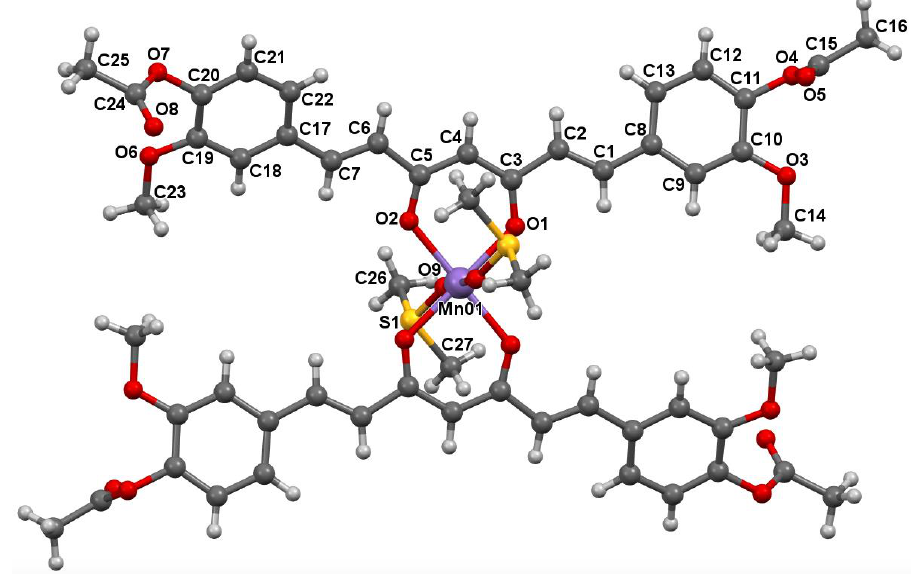
Figure 5. Molecular structure of 5 . Hydrogen atoms are drawn as circles with an arbitrary radius. Selected bond distances and bond angles for compounds 2 , 3 , 4, and 5 are listed in Table S1. The values of the M-O bond distances of the metal complexes DAC and the corresponding metal acetylacetonates are shown in the Table 7, showing great similarity among them [32 – 38].